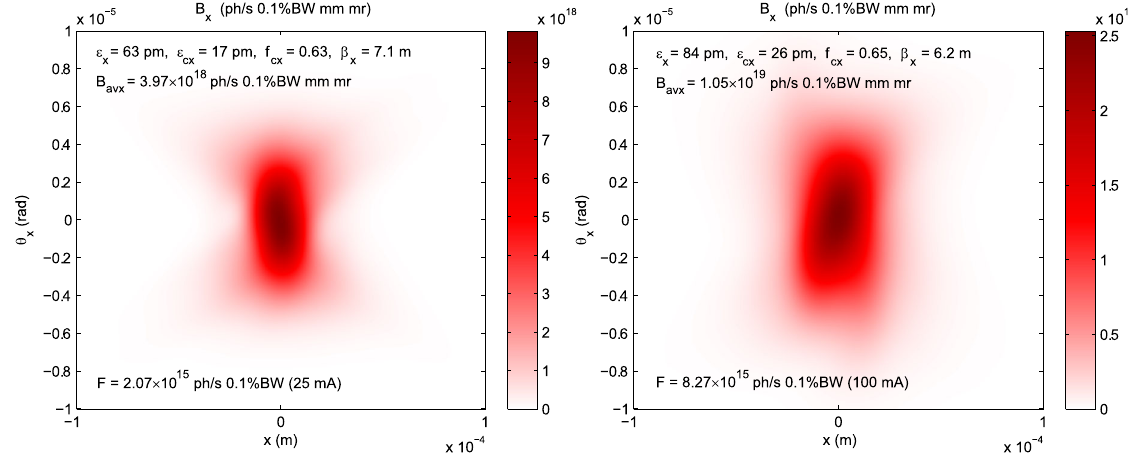
FIG. 21. X-ray phase space including the effects of emittance and energy spread for the two different